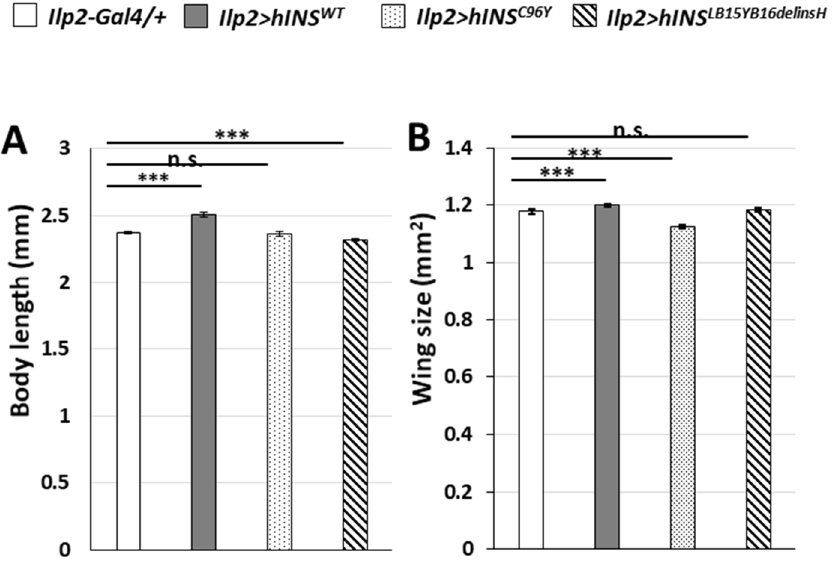
Figure 4. The ectopic expression of human mutant preproinsulin in IPCs resulted in the production of smaller adults indicating growth inhibition. ( A , B ) Adult phenotypes in male flies derived from individuals harboring targeted expression of human preproinsulin in IPCs throughout development. Note that the expression of hINS WT in IPCs stimulated Drosophila growth, while either of hINS C96Y or hINS LB15YB16delinsH failed. ( A ) Quantification of body length of male adults ( n > 69, n.s.: not significant, *** p < 0.001, Student’s t -test). Error bars represent SEMs. ( B ) Quantification of wing size of the male adults ( n > 113, n.s.: not significant, *** p < 0.001, Student’s t -test). Error bars represent SEMs.